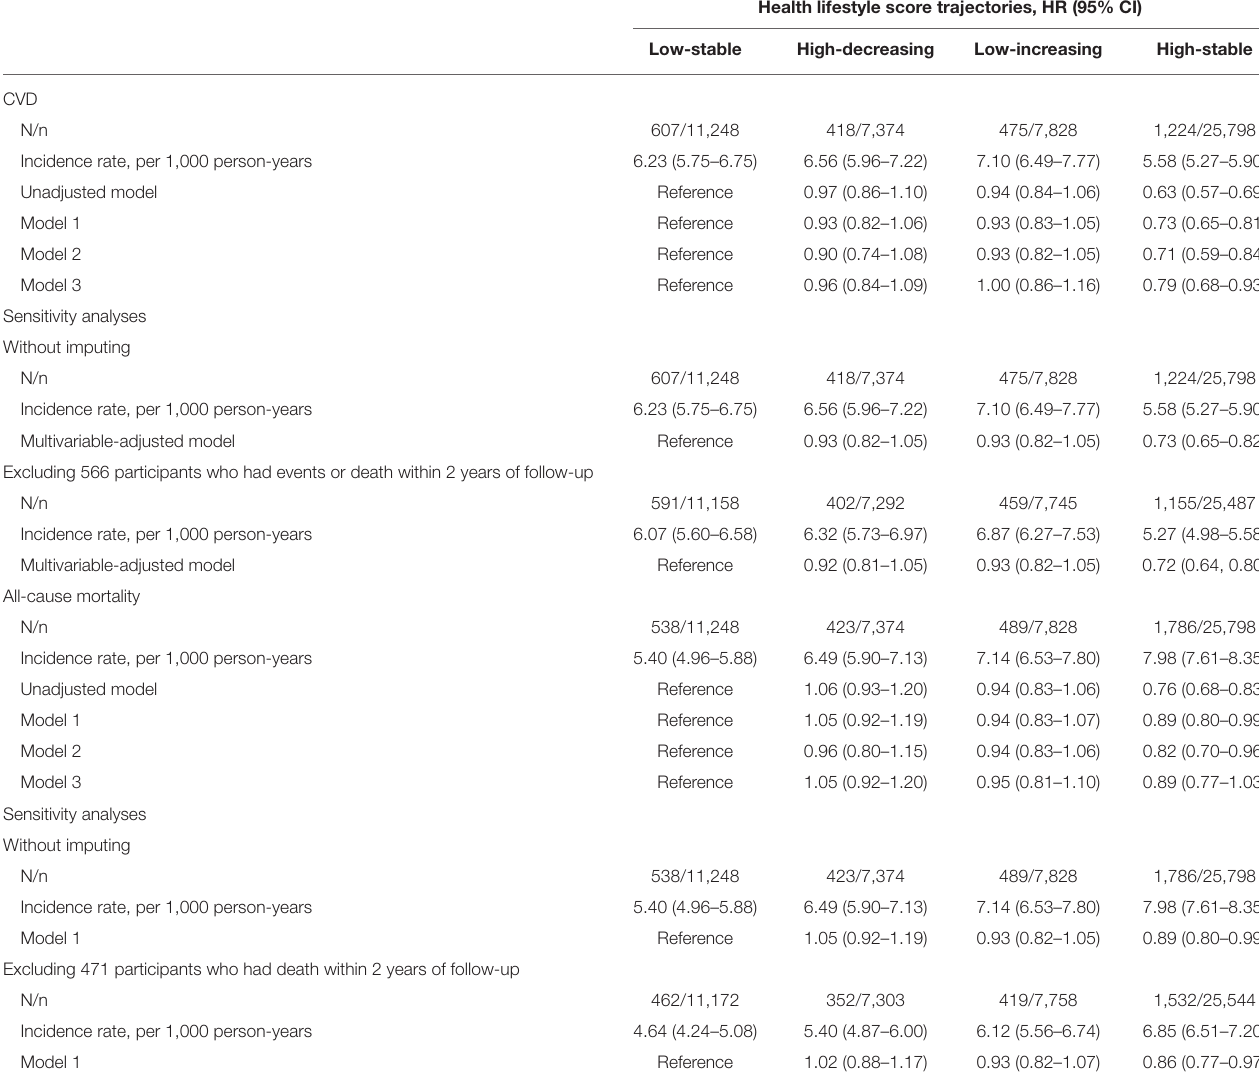
TABLE 2 | Incidence of CVD and all-cause mortality according to healthy lifestyle score trajectories from 2006 to